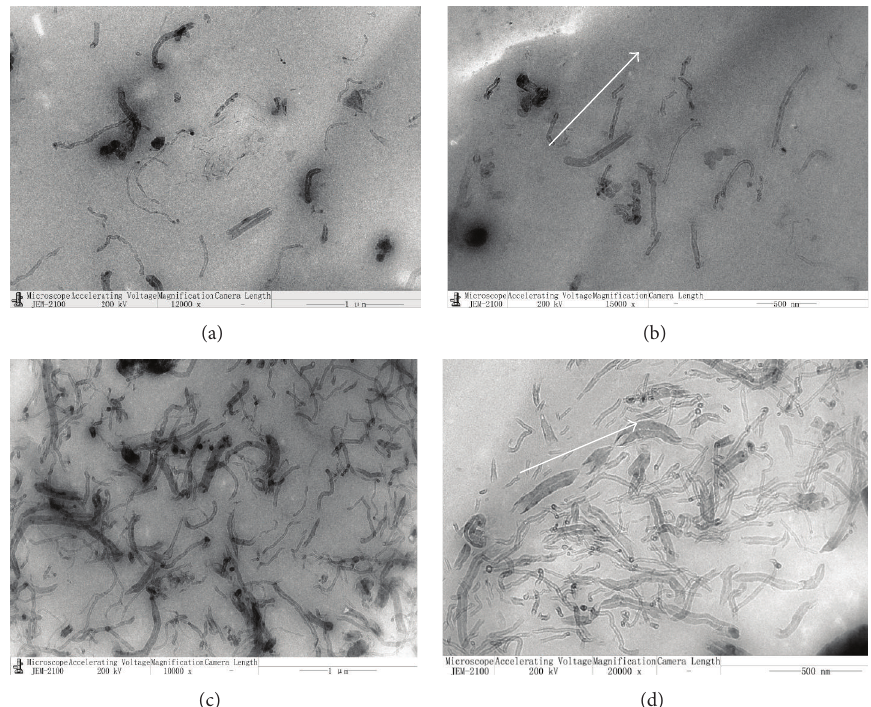
Figure 3: (a) and (c) are TEM images of composite with random MWCNTs at the volume fraction of 2% and 6%, respectively. (b) and (d) are TEM images of composite containing 2 vol. % and 6 vol. % of MWCNTs oriented by a shear flow, respectively.